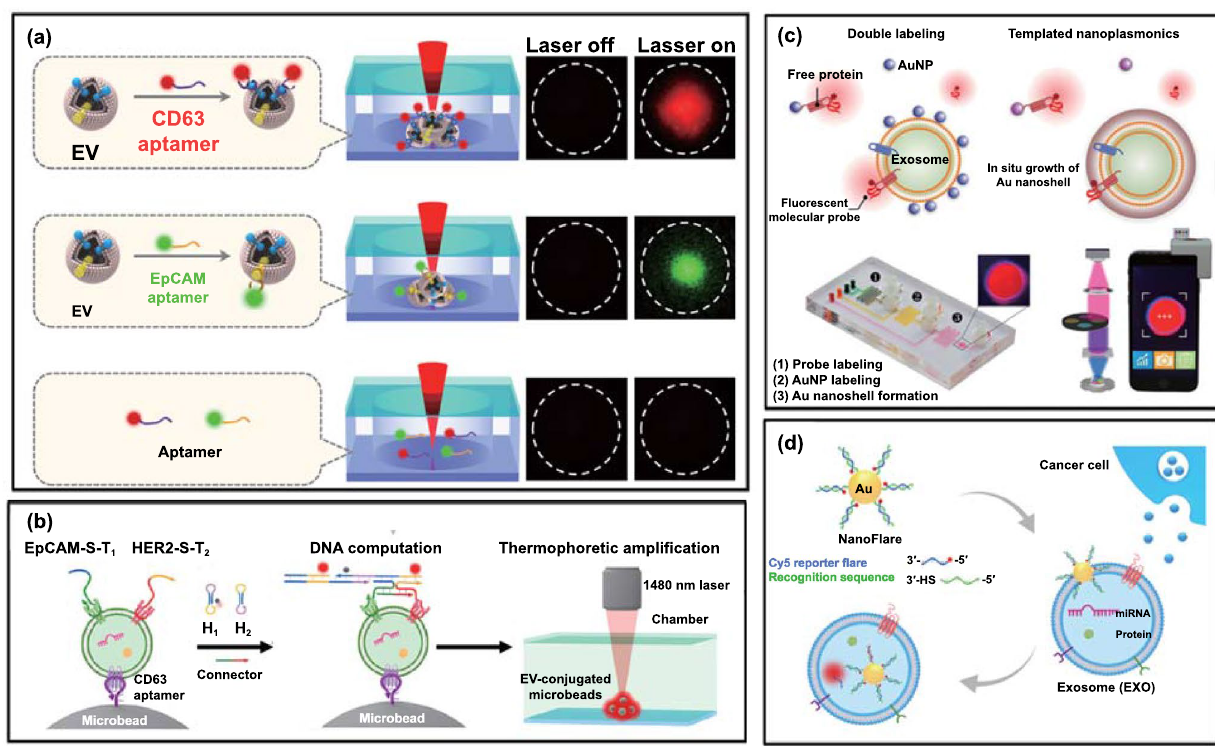
Fig. 5 Chemical coding strategies with signal amplification for EV multiplexing. a An aptasensor for the thermophoretic enrichment of EVs and multiplexed profiling of their surface proteins. Reproduced with permission from Ref. [57]. Copyright 2019 Springer Nature. b DNA liga- tion system for EV membrane protein profiling using thermophoresis. Reproduced with permission from Ref. [69]. Copyright 2021 American Chemical Society. c Schematic of the TPEX microfluidic multiplexing platform. Exosomes were incubated with different fluorescent aptamers, either individually (singleplex) or as a mixture (multiplex), for templated plasmonics for exosome (TPEX) analysis. Reproduced with permission from Ref. [63]. Copyright 2020 American Association for the Advancement of Science (AAAS). d Thermophoretic sensor implemented with nanoflares for in situ detection of exosomal miRNAs. Reproduced with permission from Ref. [70]. Copyright 2020 American Chemical